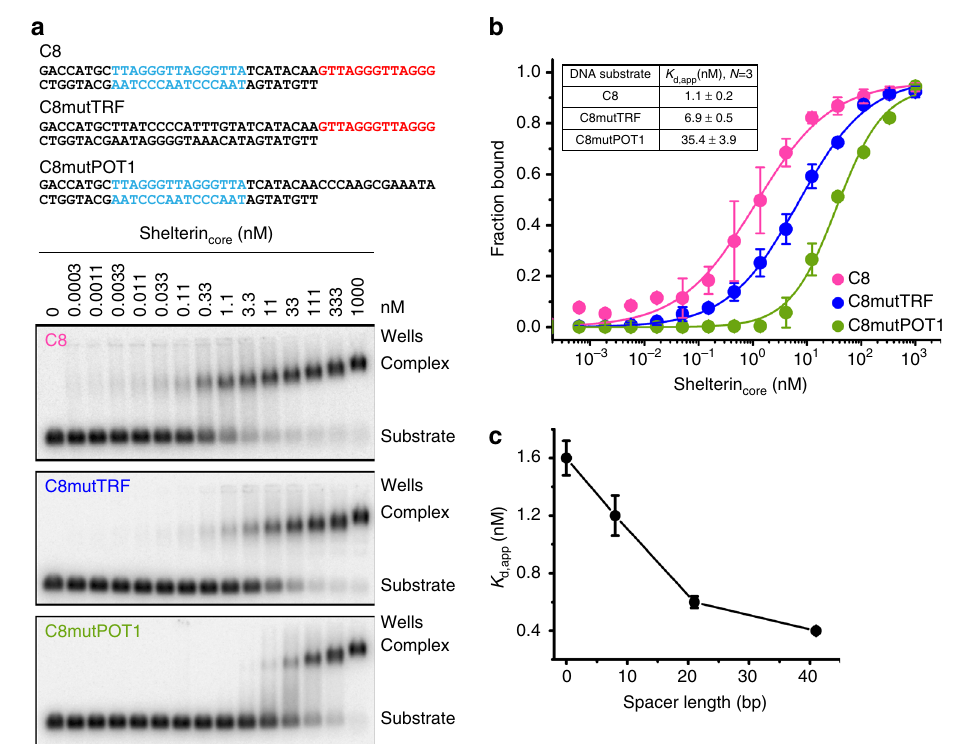
Fig. 2 Shelterin core complex binds strongest to telomeric DNA with both single-stranded and double-stranded regions. a Representative Ag-EMSA shows shelterin core complex binding to a telomeric DNA substrate (C8) with binding sites for both TRF2 dimer and POT1 and to C8mutTRF and C8mutPOT1, which have mutated TRF2 dimer and POT1-binding sites, respectively. b The equilibrium dissociation constants ( K d,app ) were determined through curve fi tting (with Hill equation) from the Ag-EMSA gels. Error bars represent s.d. ( n = 3 independent experiments). c Binding af fi nity increases some what with increasing spacer length (base pairs) between TRF2 dimer and POT1-binding sites. (Error bars are s.d., n = 3 independent